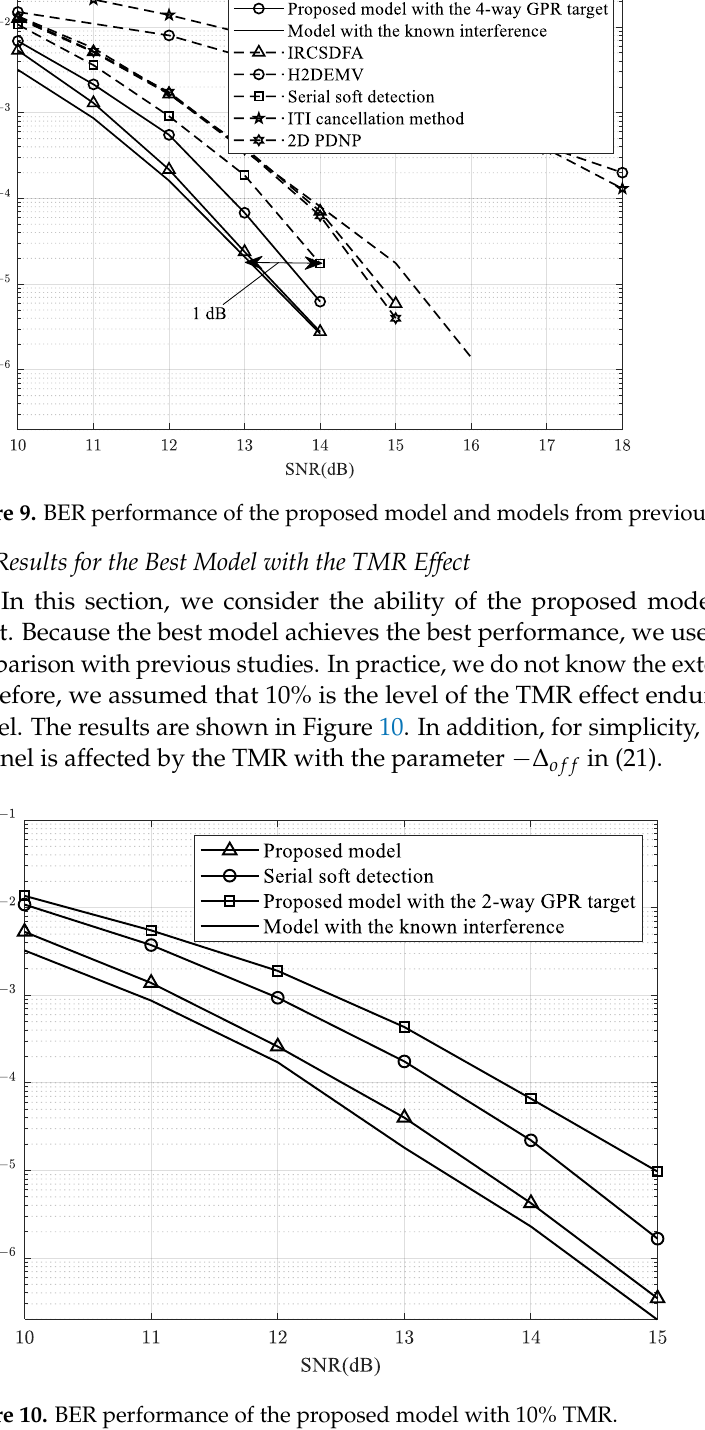
Figure 10. BER performance of the proposed model with 10% TMR.